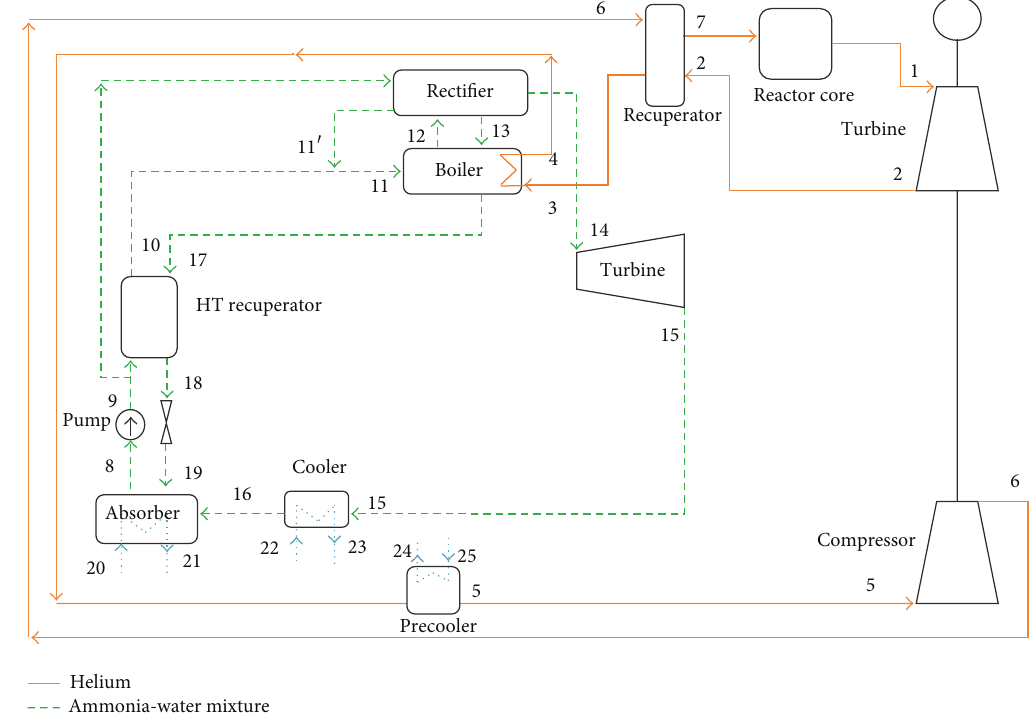
Figure 1: Schematic diagram of the combined